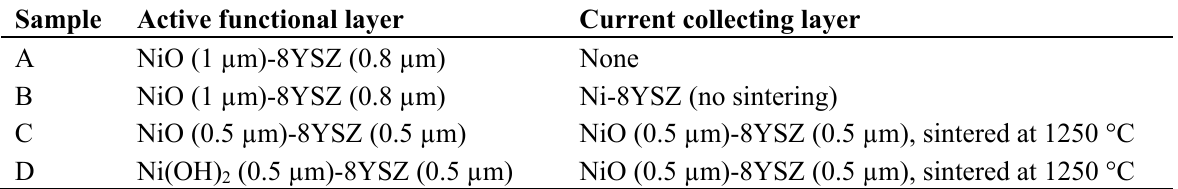
Table 6. Composition and microstructure of the active and current collecting layer anode (the composition is always 65:35 mol % Ni:8YSZ for all layers and the active layer is sintered in all cases at 1350 °C)